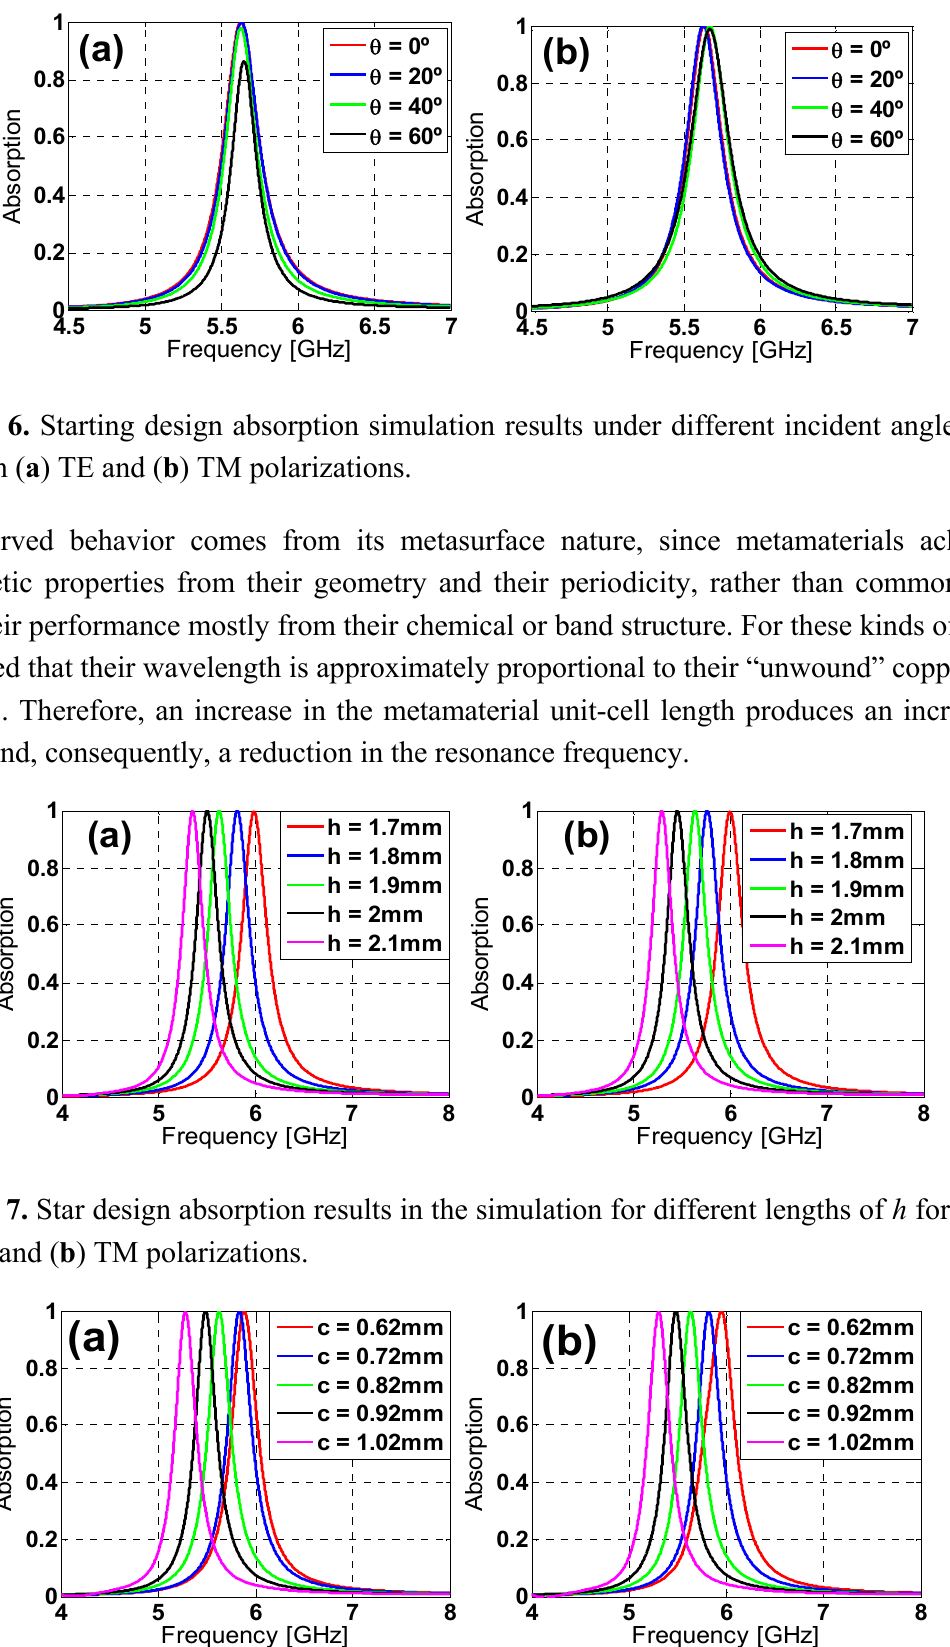
Figure 8. Star design absorption results in the simulation for different sizes of c for both ( a ) TE and ( b ) TM